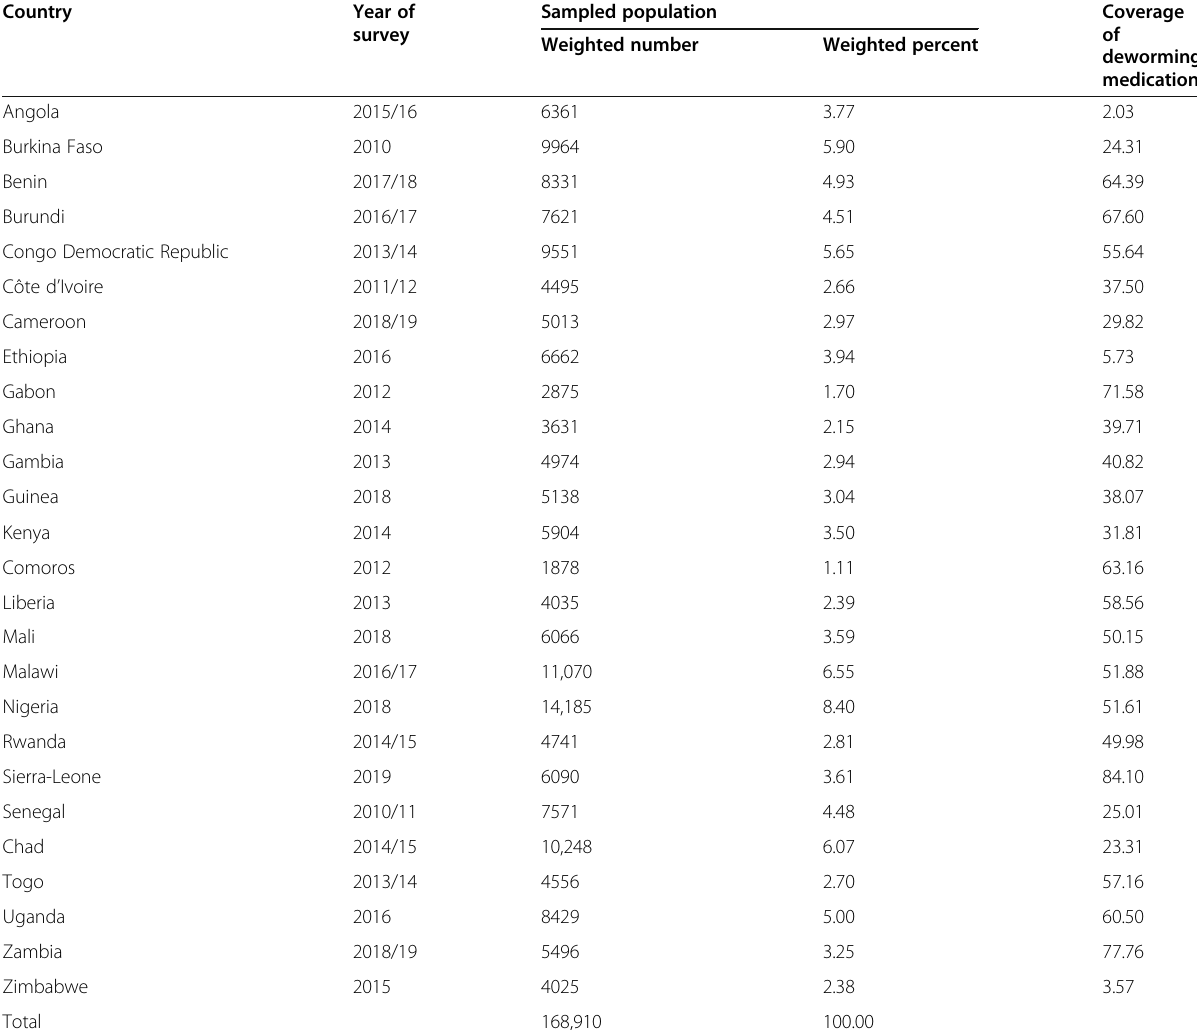
Table 1 Year of survey for each studied countries and sampled population Country Year of